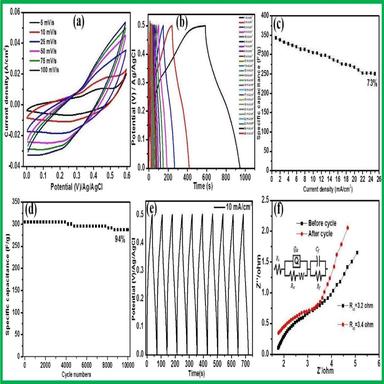
(a) CV curves of CuCo2O4 nanowires at different scan rates (5e100 mV s1 ) in the potential range of 0 to þ0.6 V vs Ag/AgCl in 2 M KOH (b) Galvanostatic charge discharge studies of CuCo2O4 nanowires at different densities (1e25 mA cm2 ) in the potential range of 0 to þ0.5 V vs Ag/AgCl in 2 M KOH (c) Function of specific capacitance at different current densities of CuCo2O4 nanowires (d) Galvanostatic charge discharge cycles of CuCo2O4 nanowires at a current density of 10 mA cm2 (e) cycling stability of CuCo2